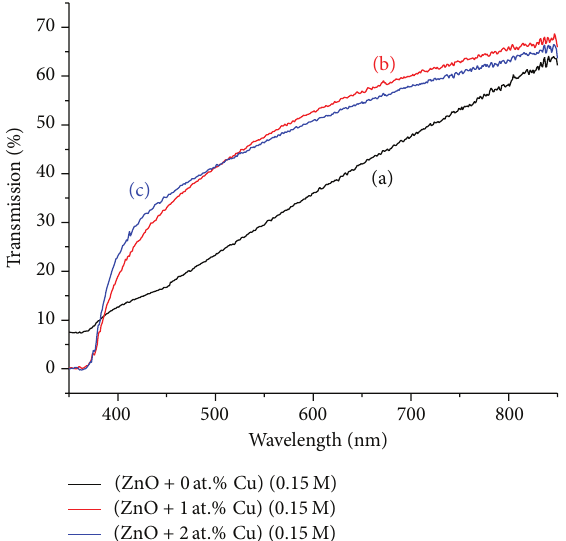
Figure 4: Transmission spectra of undoped and Cu doped ZnO thin films sample. Here (a), (b), and (c) correspond to samples Z2, Z2C1, and Z2C2, respectively, prepared using precursor solution of molarity of